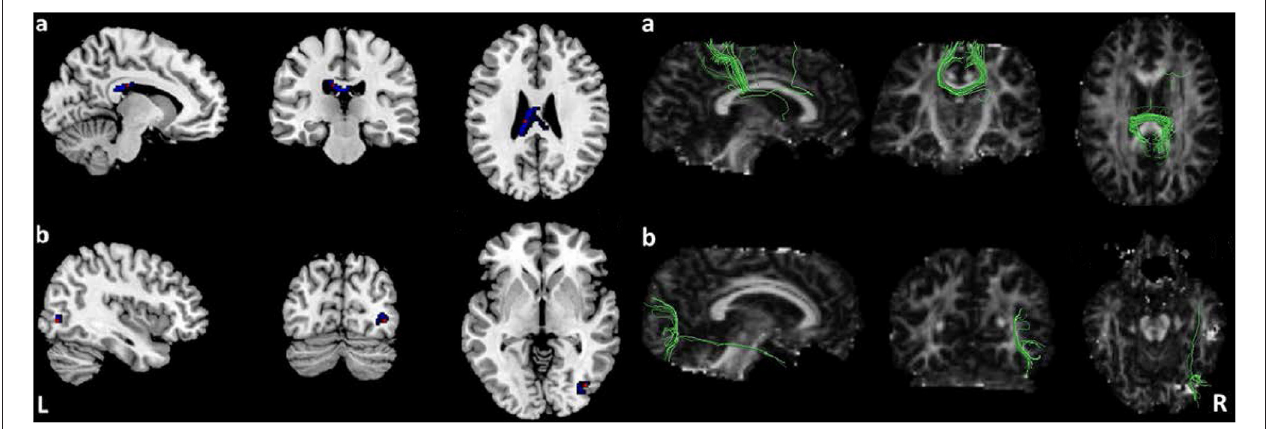
FIGURE 2 | Results of pooled meta-analysis. Decreased FA of the CC (a) and right ILF (b) in TS patients compared with HCs and cluster-related white mater diffusion tensor tracts. Regions with blue color area showed lower FA in TS, red dots represent the peak coordinate. FA, fractional anisotropy; TS, Tourette syndrome; HCs, healthy controls; CC, corpus callosum; ILF, inferior longitudinal fasciculus. TABLE 4 | Clusters of fractional anisotropy reductions in TBSS method studies. Region MNI coordinates SDM p -value No. voxels Cluster breakdown x , y , z Z -value (voxels)